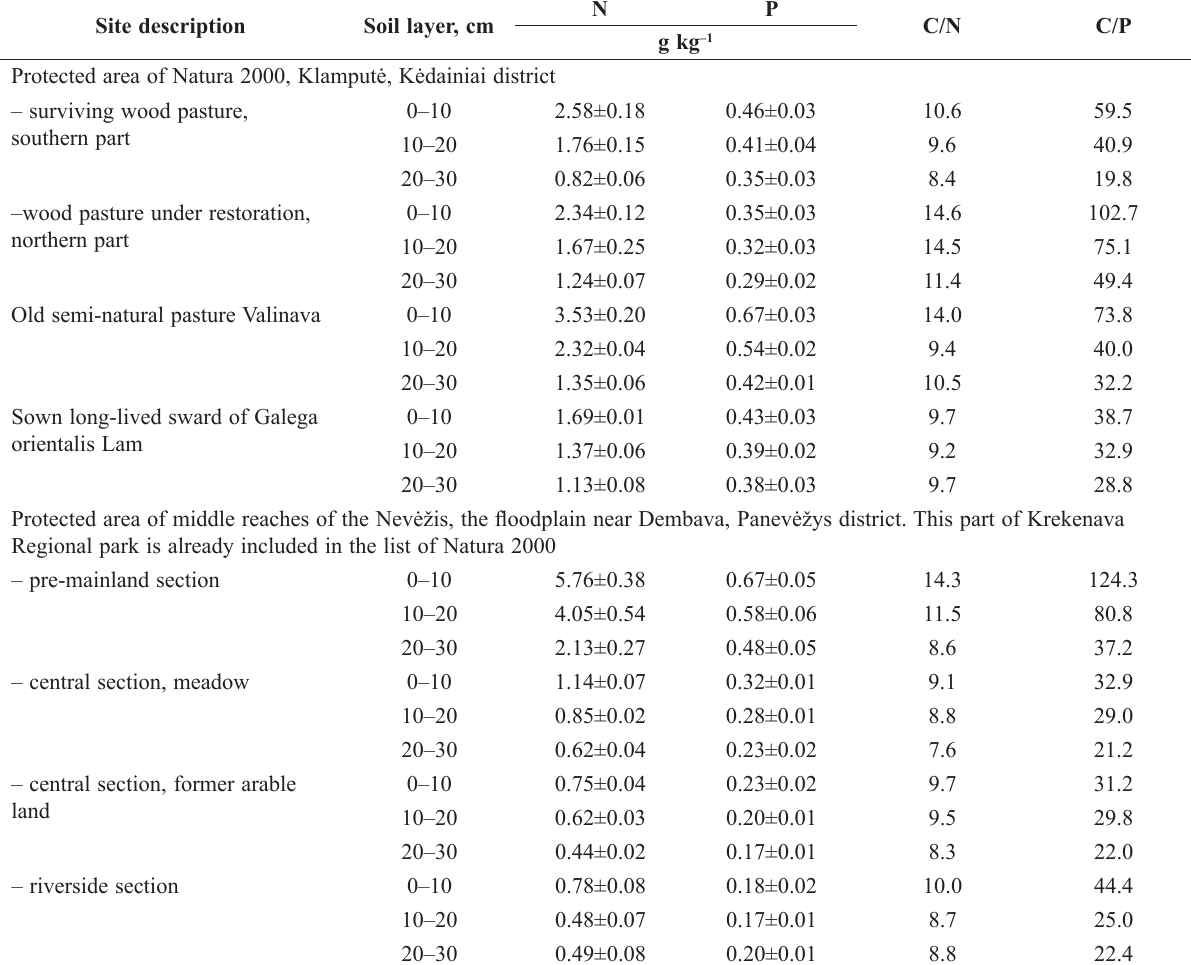
Table 2. The soil variables of protected areas and agricultural lands, 2012 site description soil layer,